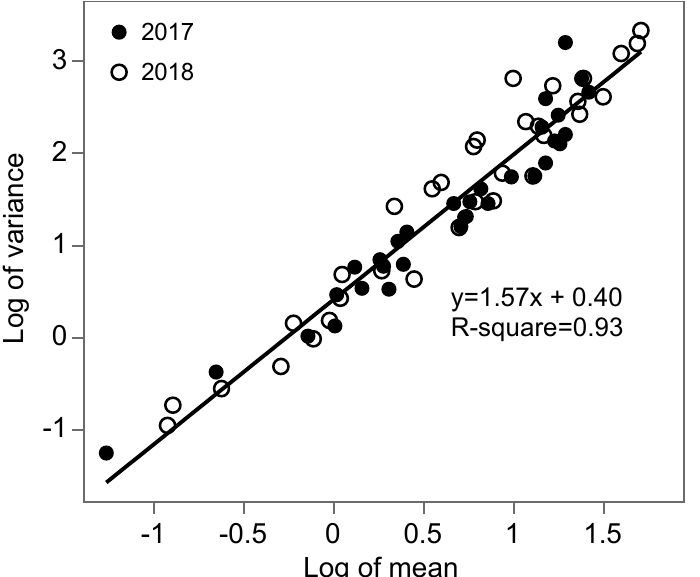
Figure 2. Linear relationship between field variances and means ( n = 70) of S. dorsalis counts from leaf samples collected from fourteen blueberry fields in central Florida during summers of 2017 and 2018.